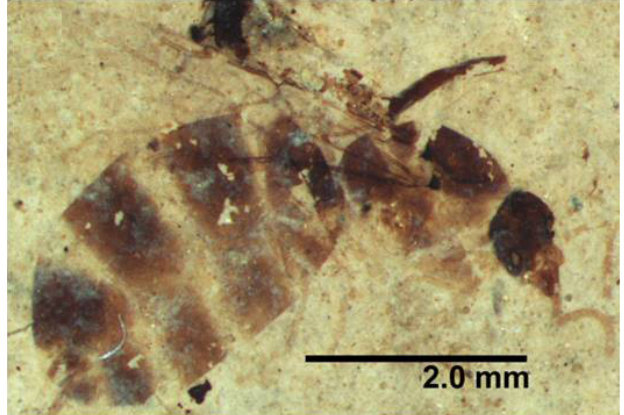
Fig 4. Holotype queen, Proiridomyrmex rotundatus (USNM# 609586).